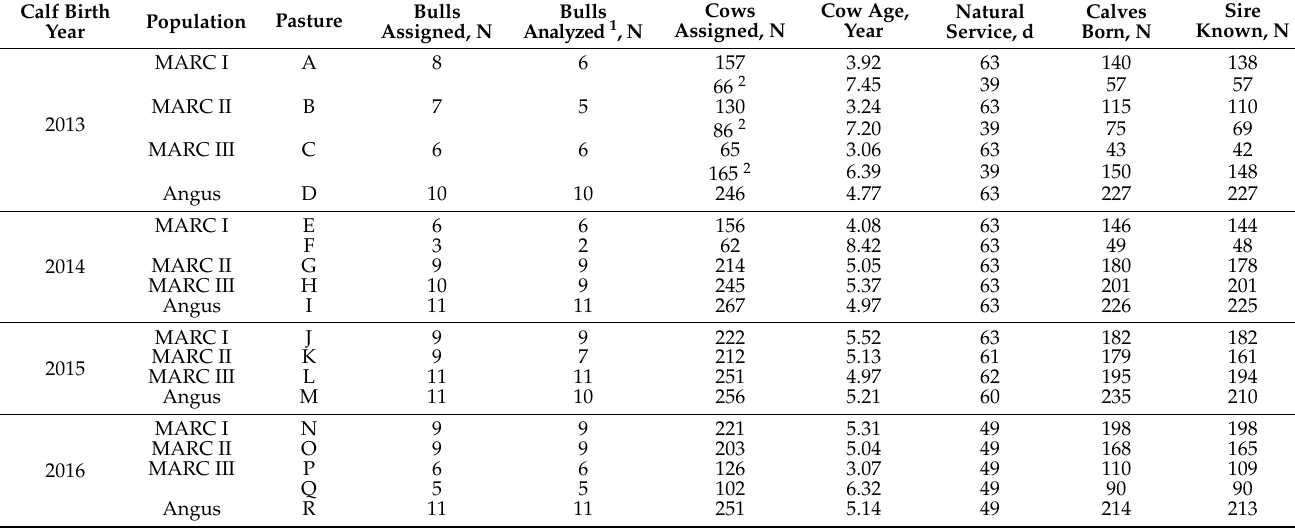
Table 1. Natural service assignments of bulls and cows and resulting calves. Calf Birth Year